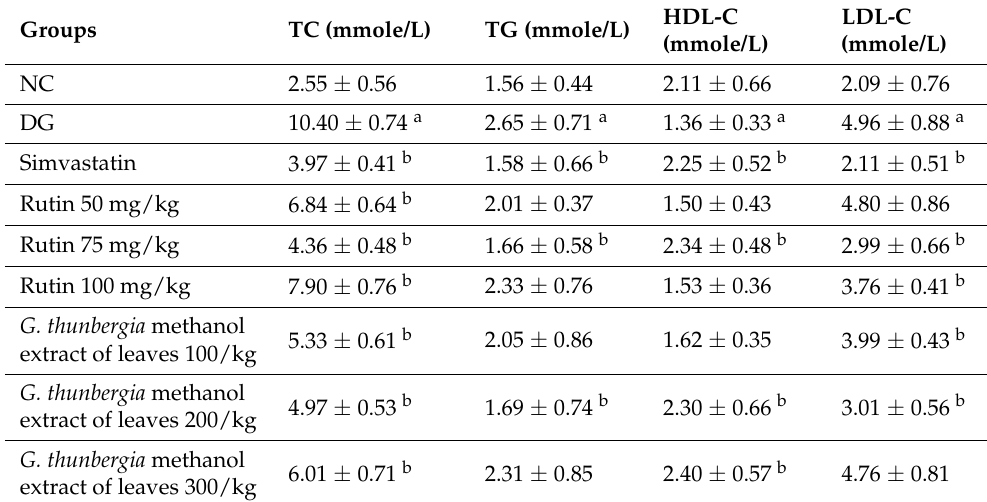
Table 3. Effect of rutin and leaves methanol extract on the lipid profile of mice.